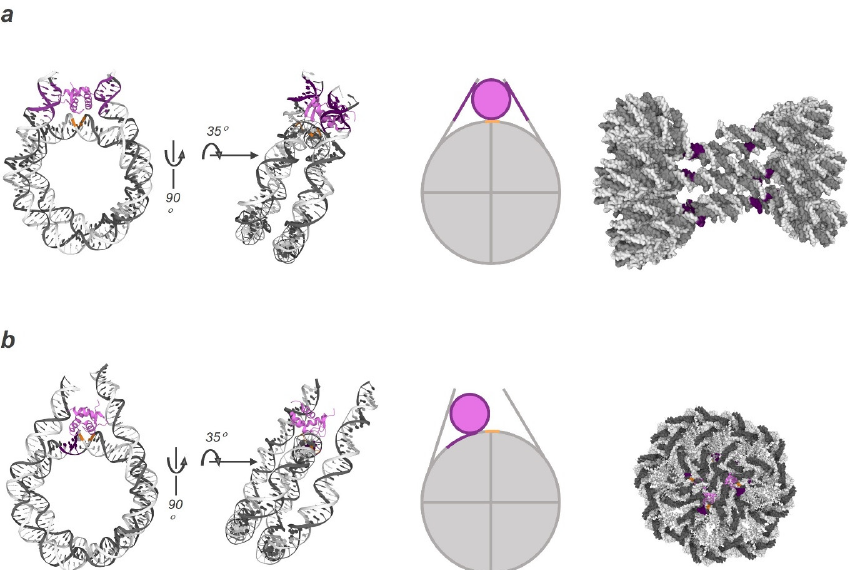
Figure 2. Chromatosome structure: the on- and off-dyad binding model. Cartoon representation of nucleosomal DNA (in grey and white) and a linker histone (purple). The DNA positions juxtaposed to the protein are highlighted in magenta, and the dyad in orange. Core histones are not shown for clarity. ( a ) Nuclear magnetic resonance structure of the NCP core with 167 bp DNA based on Widom’s “601” sequence in complex with the globular domain (GD) of chicken linker histone H5 (PDB ID: 4QLC). The linker histone is engaged in stable symmetric interactions with the dyad and both DNA linkers. Such interactions induce the formation of a ladder-like conformation of the chromatin fibre. ( b ) Nuclear magnetic resonance structure of the NCP core with 197 bp DNA based on Widom’s “601” sequence in complex with human linker histone H1.4 (PDB ID: 7PFD). The linker histone is displaced from the dyad position towards one of the linker regions. This interaction is affected by the local nucleosome environment and leads to twisted geometry of the fibre confor- mation.